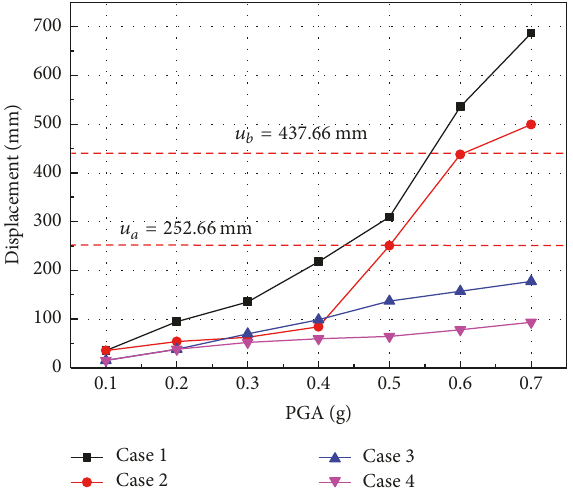
Figure 19: Maximum displacements of laminated elastomeric bear- ings.